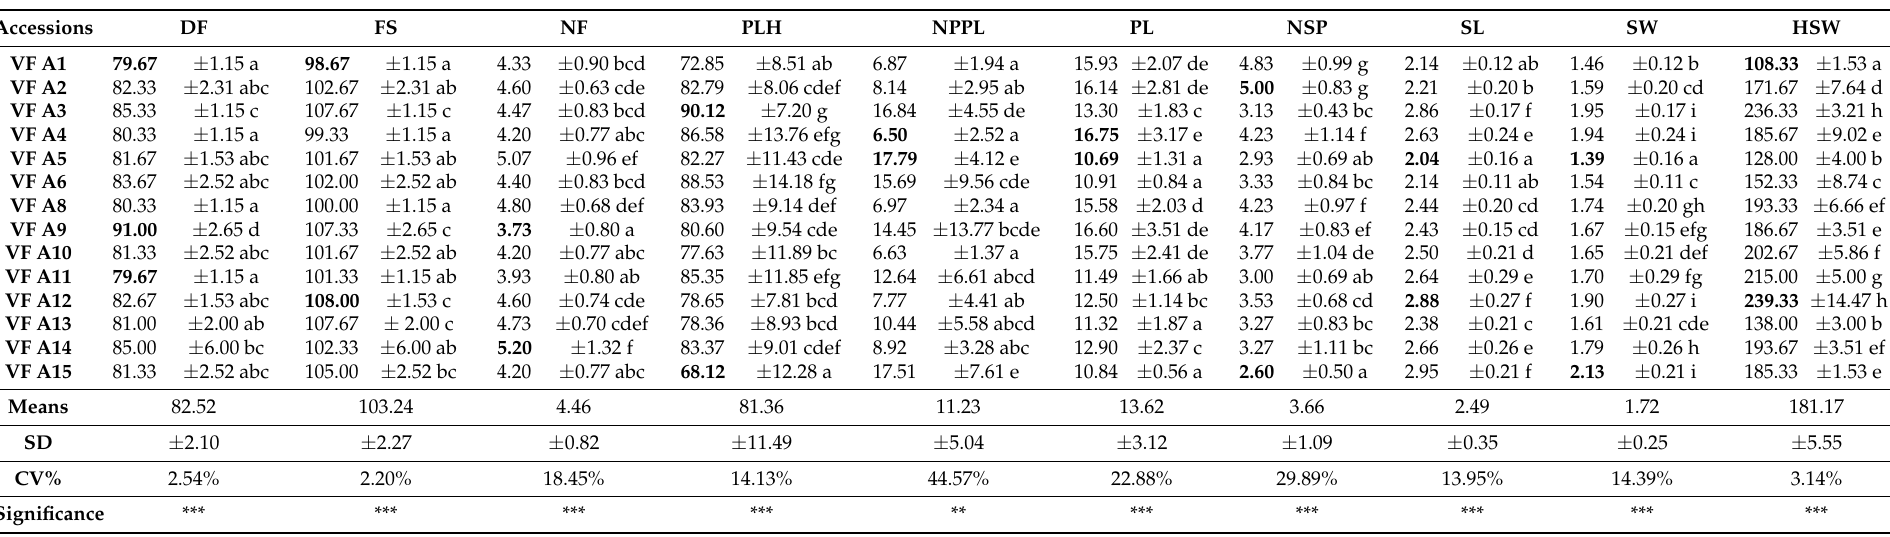
Table 1. Summary statistics of 10 agro-morphologic traits measured in 14 Algerian faba bean